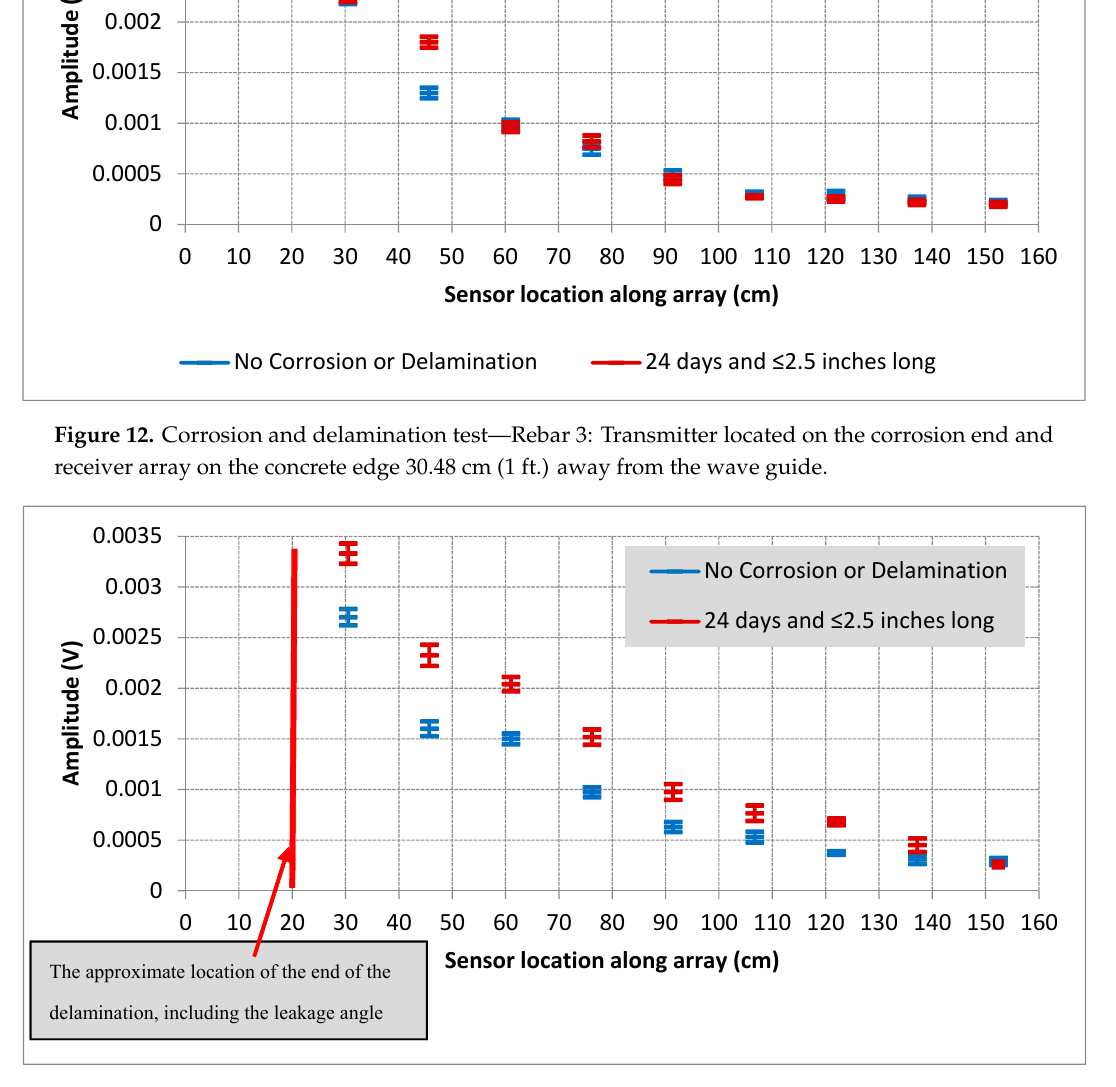
Figure 13. Corrosion and delamination test—Rebar 3: Transmitter located on the delamination end and receivers on the concrete edge 30.48 cm (1 ft) away from the wave guide.